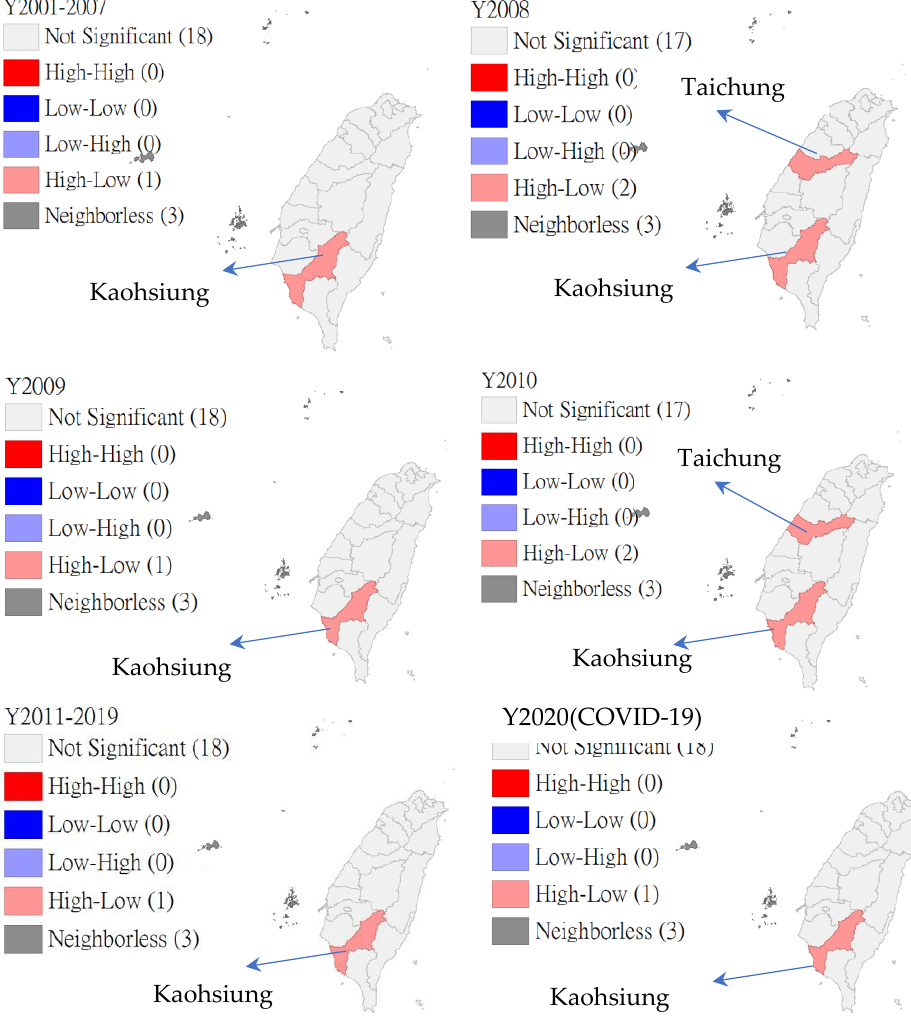
Table 4. Unit root test. Unit Root Test Stat. p -Value H 0 : Panels contain unit roots